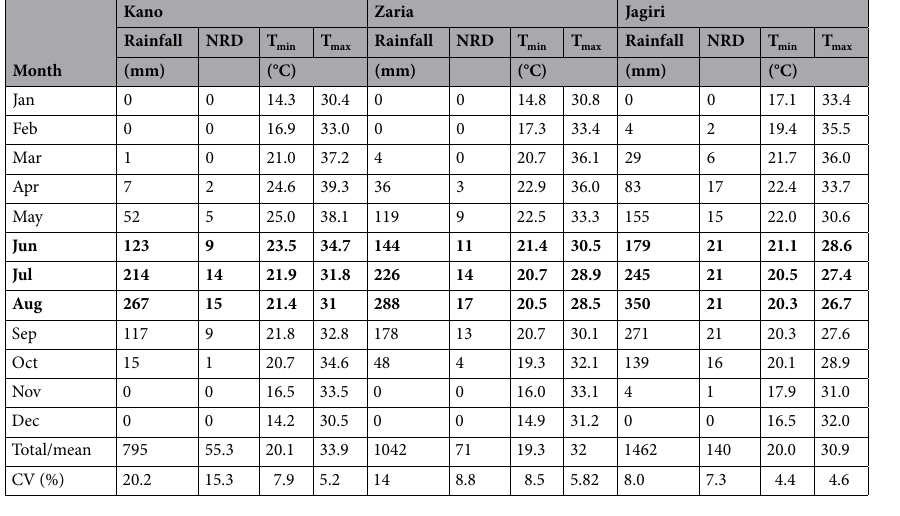
Table 2. Long-term (1985–2014) Monthly variation of rainfall, number of rainy days (NRD), minimum temperature (Tmin) and maximum temperature (Tmax) in Kano (Sudan Savanna), Zaria (northern Guinea savanna) and Jagiri (southern Guinea savanna). The bold represents sowing months used for the simulation.